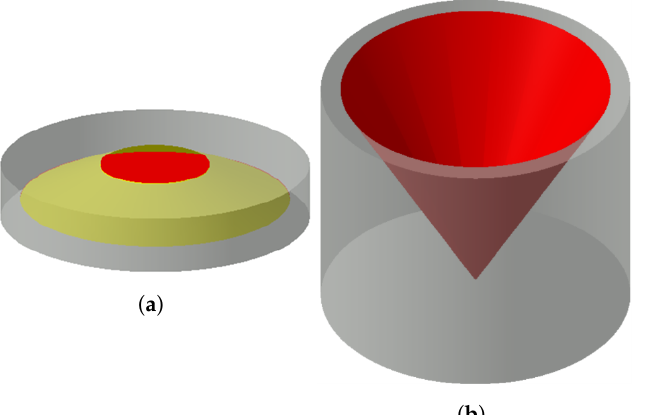
Figure 5. Cavity designs for analytical investigation: ( a ) positive conical cavity; ( b ) negative conical cavity.